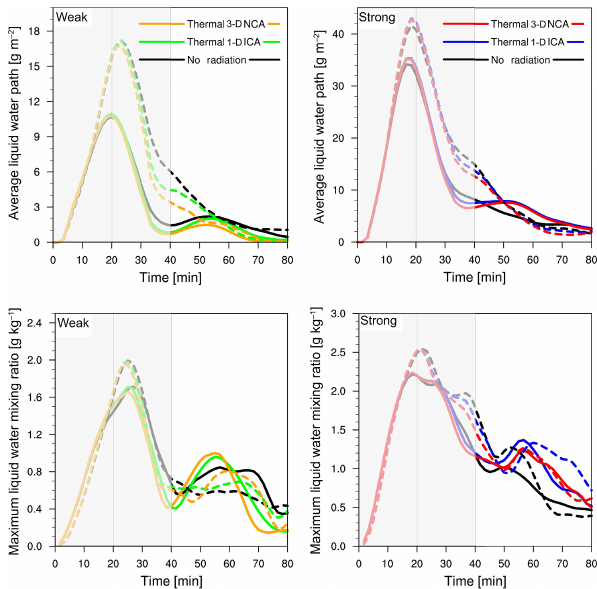
Figure 3. Time development of the conditionally sampled liquid water path and maximum liquid water mixing ratio for the simula- tions of the single clouds. Only liquid water belonging to the single cloud was considered. The left column shows the weaker forced single clouds; the right column shows the stronger forced single clouds. Solid lines represent the non-symmetric cloud; dashed lines represent the symmetric